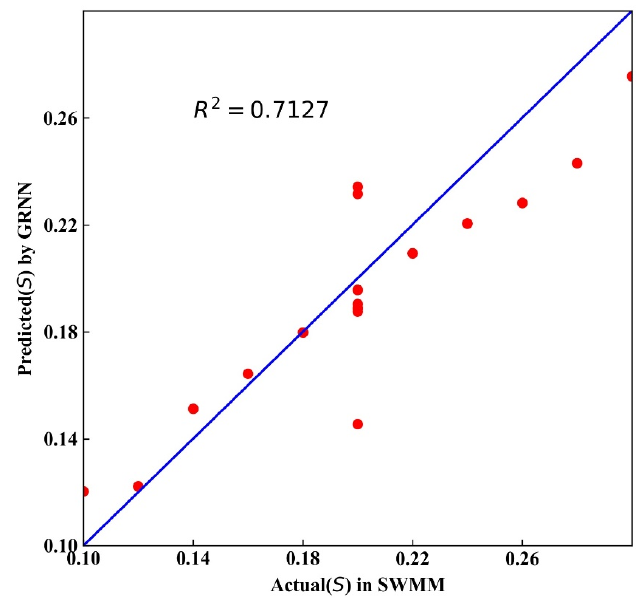
Figure 8. Relationship between actual slope (S) and predicted S values. Table 2. The hyperparameters for best results with GRNN. Table 3. Comparison of simulation results for evaluating the method